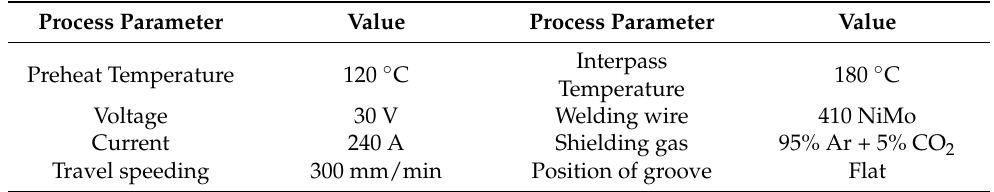
Travel speeding